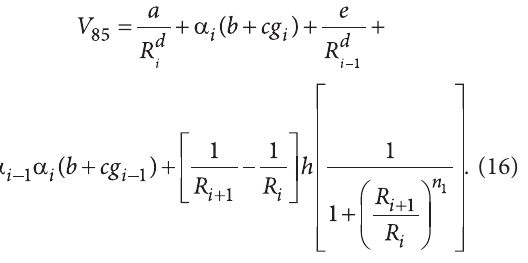
Fig. 2. Variation of F u as a function of radii ratio